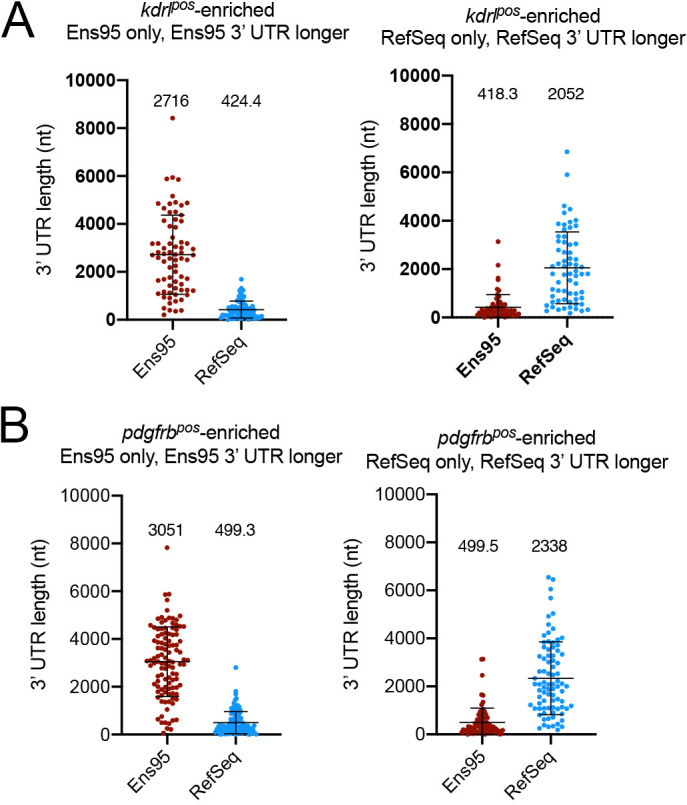
Differences in 3' UTR lengths between Ens95 and RefSeq for discrepant kdrlpos- and pdgfrbpos-enriched genes.(A, B) Plots showing 3' UTR length from matched reference genes from indicated annotation identified as enriched only in Ens95 or RefSeq. Mean 3' UTR length for each group is shown, error bars denote mean and standard deviation. No statistical comparison is presented since these data are already defined as longer (>50 nt) in indicated annotation. (A) kdrlpos-enriched genes. (B) pdgfrbpos-enriched genes.